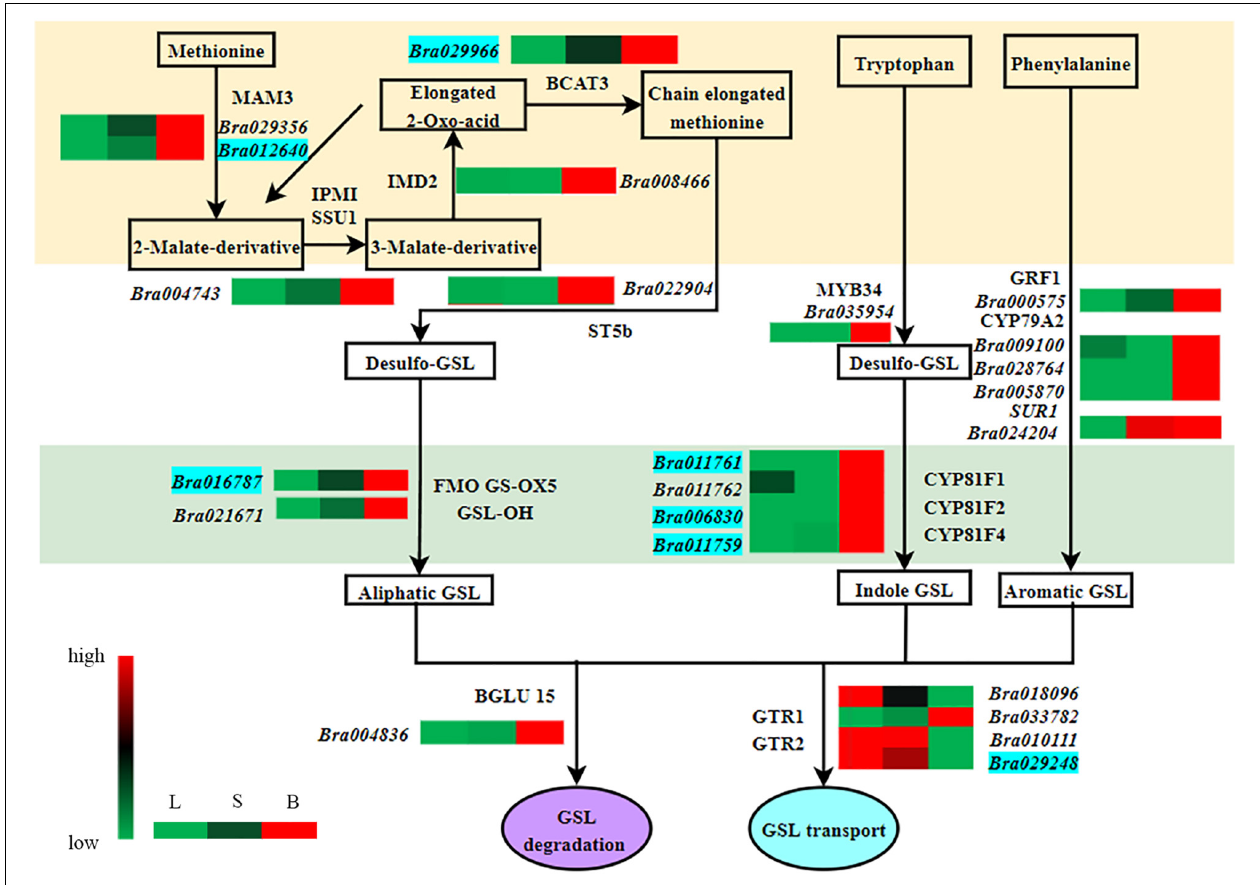
FIGURE 3 | Analysis of differentially expressed genes closely related to glucosinolate metabolism in different organs of Chinese flowering cabbage. L, leave; S, stalk; B, flower buds; Green, black, and red indicate gene expression from low to high. The genes in the blue background are strongly correlated with glucosinolate